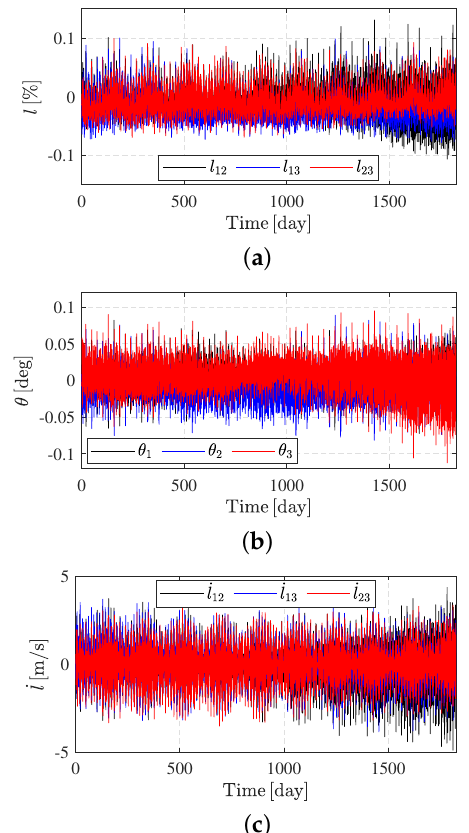
Figure 4. Changes of the stability indexes in a 5-years’ lifetime. ( a ) Arm length. ( b ) Breathing angle. ( c ) Relative